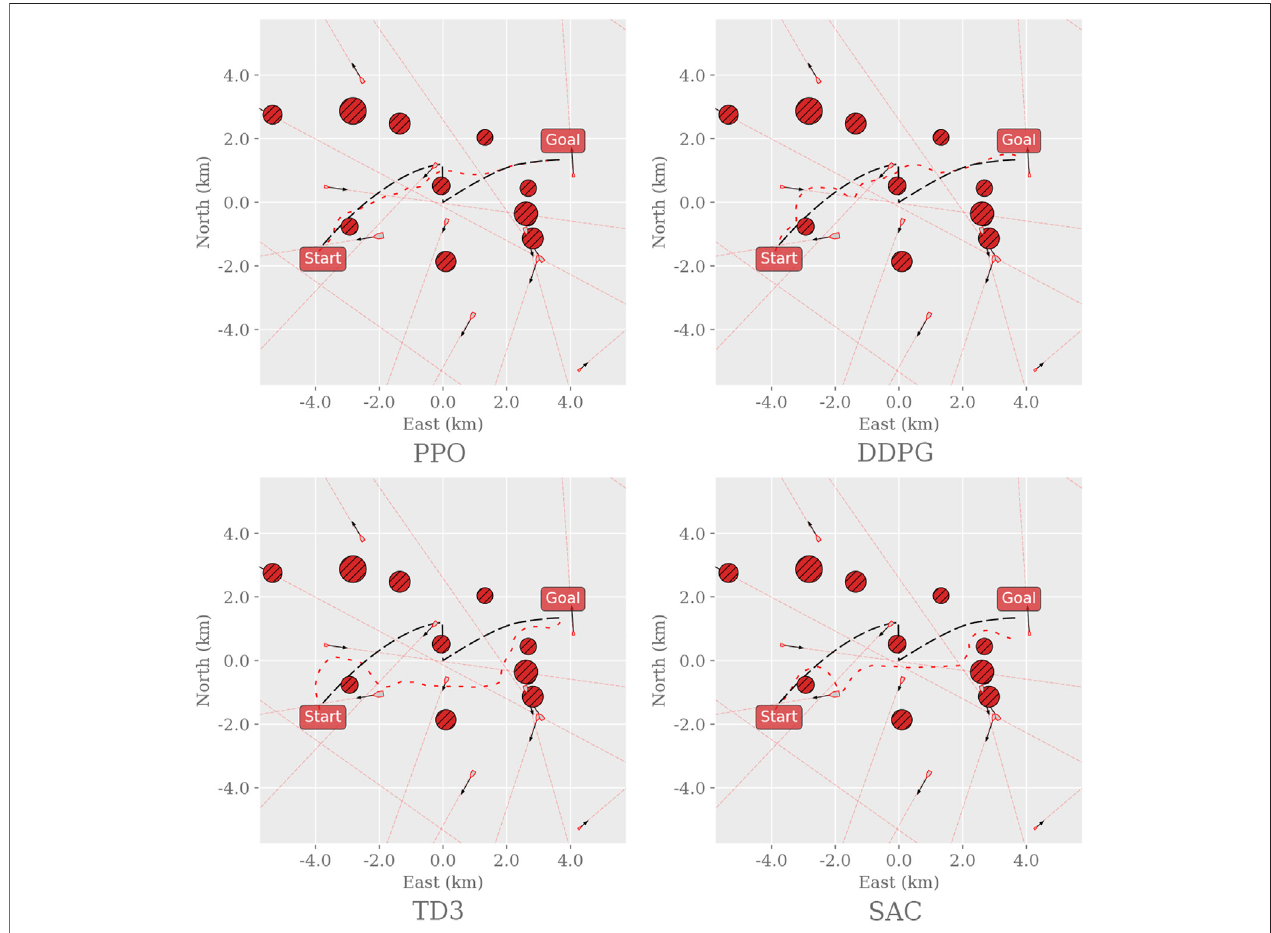
FIGURE 8 | Sample trajectories from the different RL agents acting in the MovingObstaclesNoRules environment. The agents shown was trained using the simpli fi ed reward function. Black dashed line: path to follow; red dashed line: path taken by the vessel. The environment was generated and sampled equally for all algorithms by setting the random seed to zero and using the result from the initial episode.